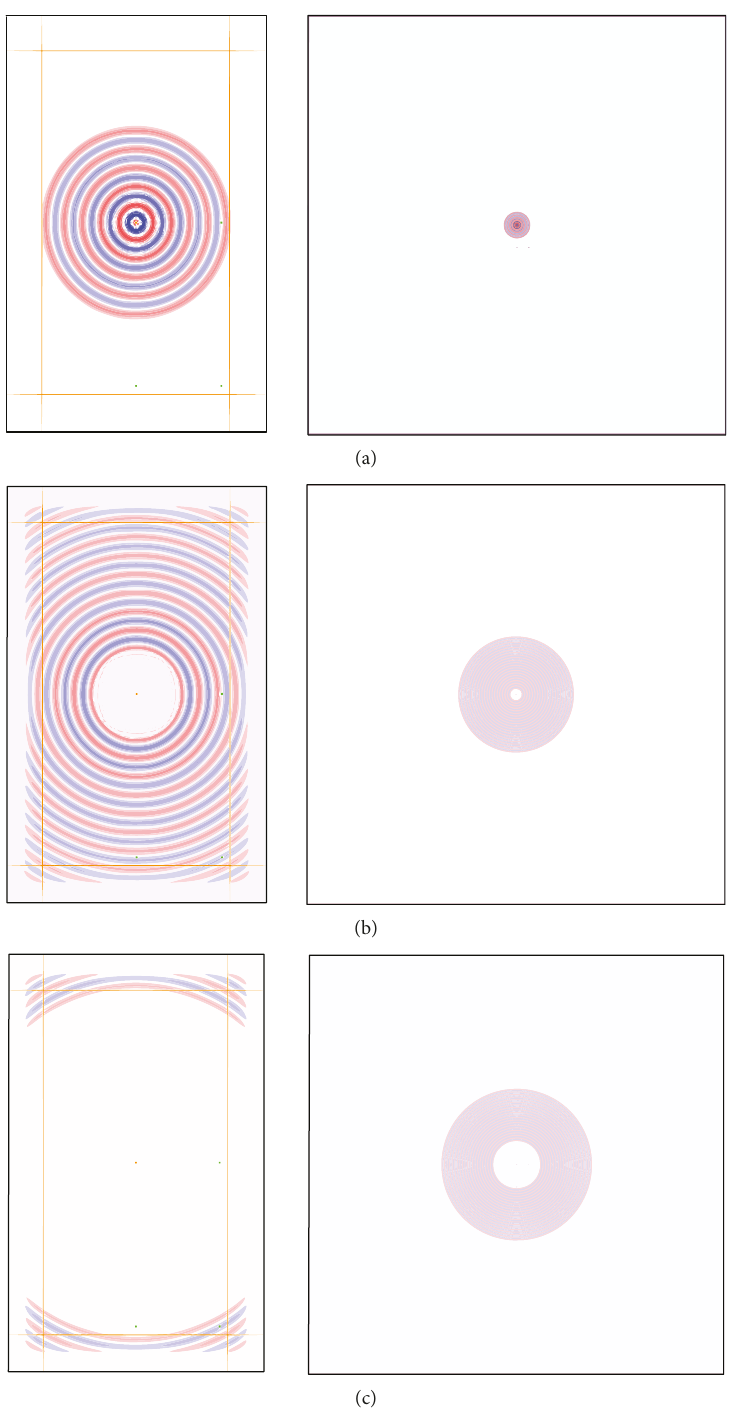
Figure 6: Electric fi eld distribution ( E z ) for free space for a 2.45GHz frequency. On the left, the FDTD-CPML case is shown, while on the right, the reference propagation (extended domain). In (a), (b), and (c), we show snapshots at n = 150,650,700, respectively. We observe an excellent wave absorption without presenting spurious re fl ected waves. The simulation lasted for 1160 time steps, and the source was turned o ff at n = 580